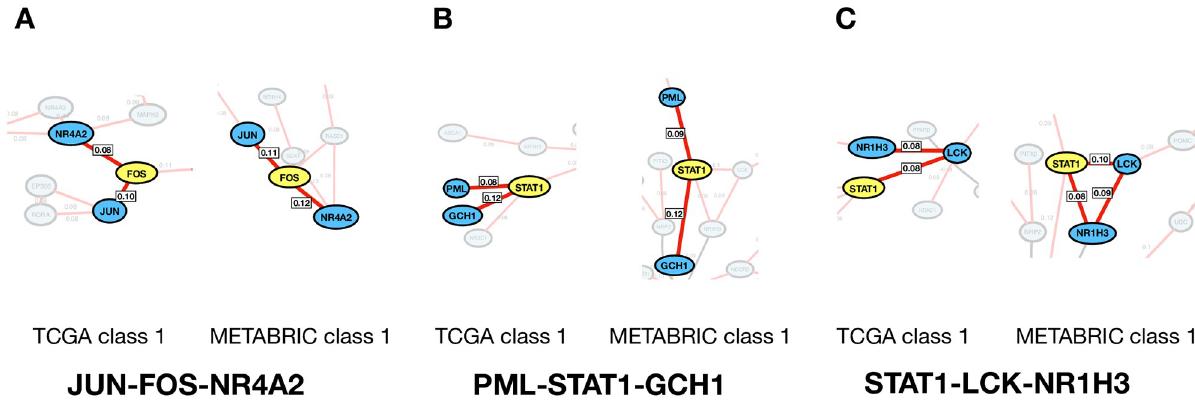
Fig 8. Three critical 3-node motifs embedded in the cropped Basal-specific networks from the Basal-like vs Luminal A comparison (TCGA and METABRIC). The 3-node network motifs are highlighted in bold in each network and are observed in the other four Basal-specific networks. See S7 Appendix for details of the networks from the other comparisons. (A) Motif JUN-FOS-NR4A2. (B) Motif PML-STAT1-GCH1. (C) Motif STAT1-LCK-NR1H3.